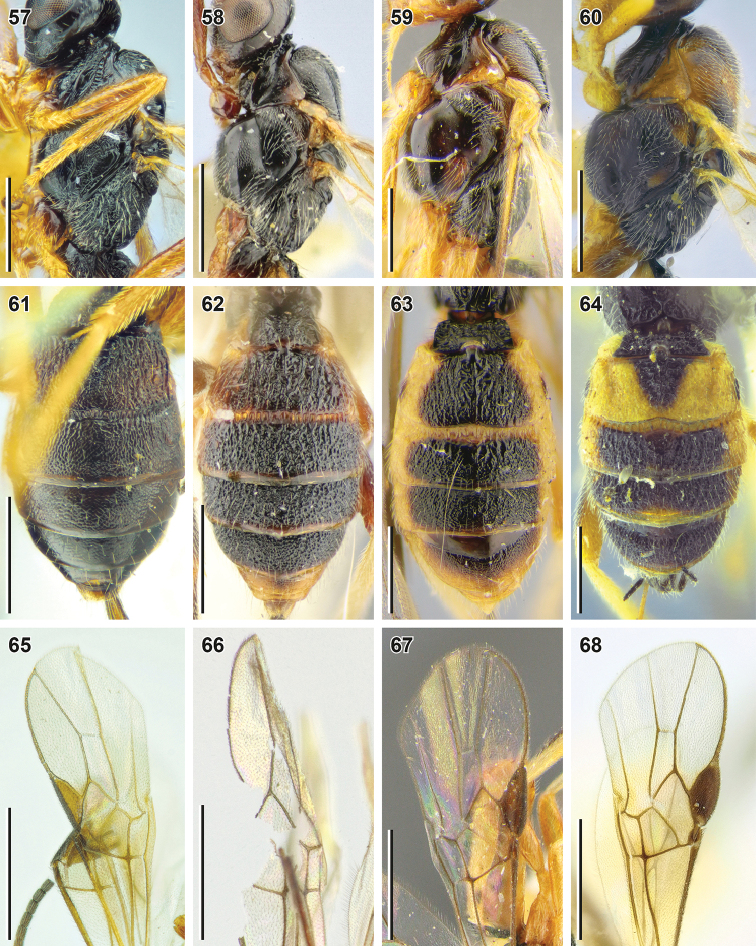
Bracon
sculptithorax Tobias, 2000 (57, 61, 65 holotype, ZISP), B.
kunashiricus Tobias, 2000 (58, 62, 66 holotype, ZISP), B.
sulciferus Tobias, 2000 (59, 63, 67 paratype, ZISP) and B.
acunens Papp, 2018 (60, 64 female, SMNE68 holotype, HNHM) 57–60 mesosoma, lateral view 51–64 metasoma, dorsal view 65–68 fore wing apex. Scale bars: 0.5 mm (57–64); 1 mm (65–68).